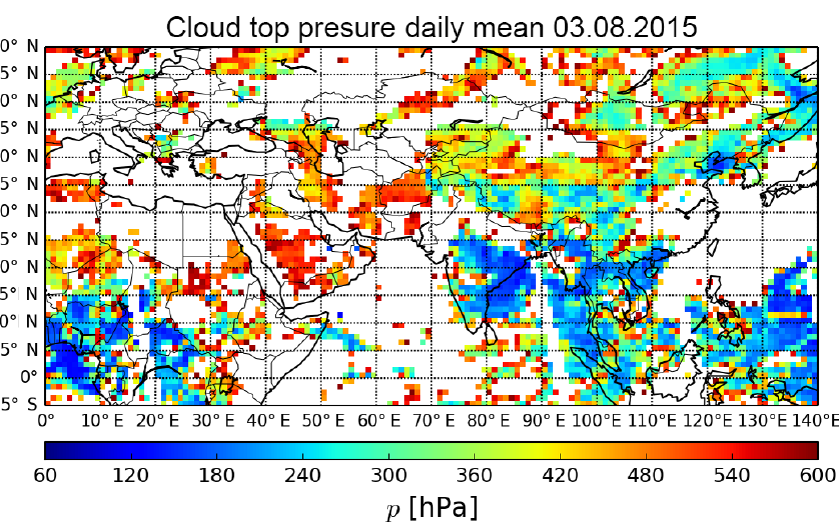
Figure 6. Satellite-derived cloud-top pressure 10 days prior (3 August 2015) to flight 19. Pressure below 250hPa represents strong convec-